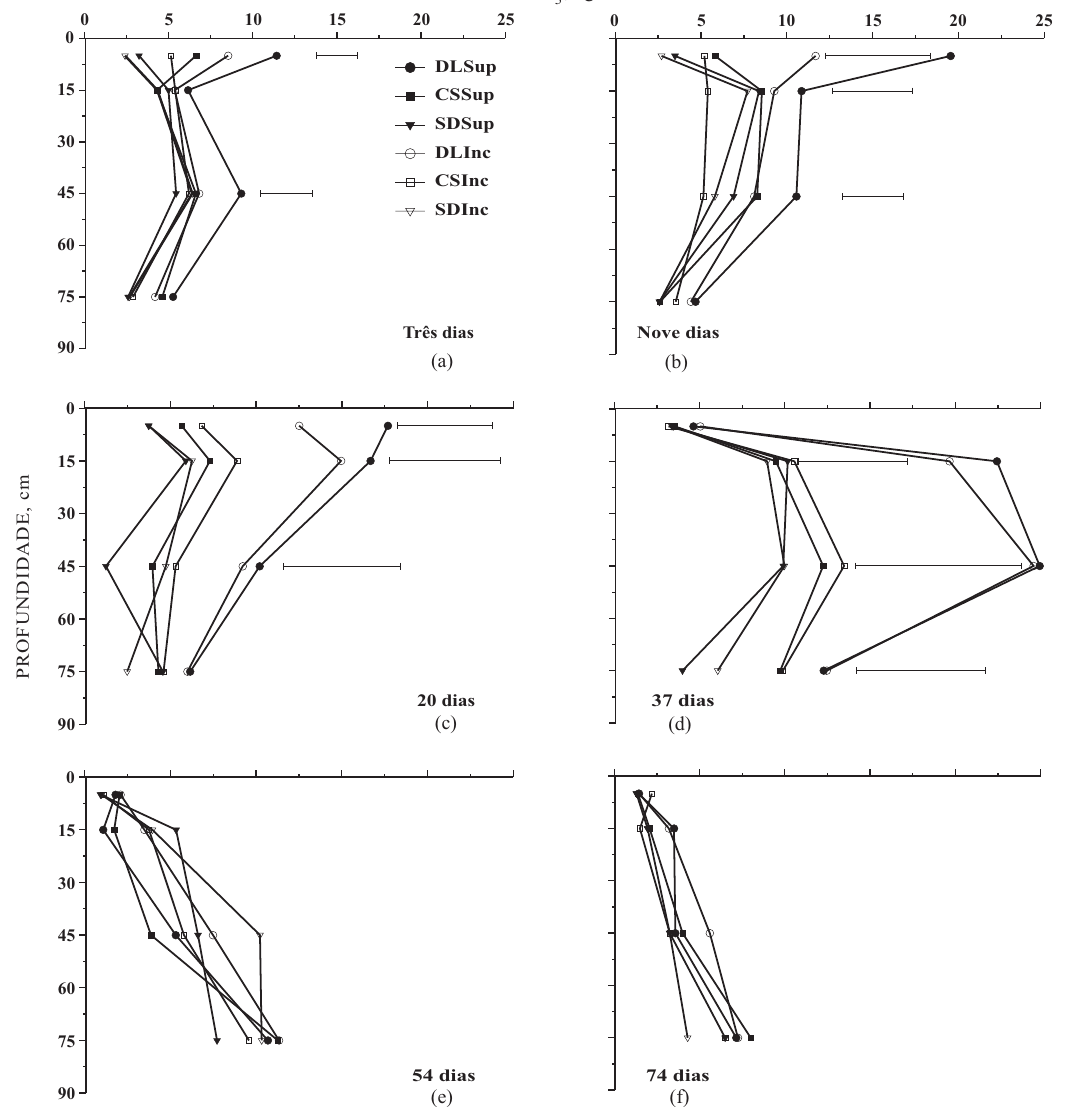
Figura 3. Quantidades de N-NO 3- na camada de 0–90 cm do solo, aos 3, 9, 20, 37, 54 e 74 dias após aplicação ou não de dejetos de suínos (líquidos e cama sobreposta) nas duas modalidades de aplicação (superfície e incorporado) no milho. Nas datas em que houve diferença significativa (Tukey a 5 %) entre as médias de cada tratamento, essas diferenças estão representadas pelas barras